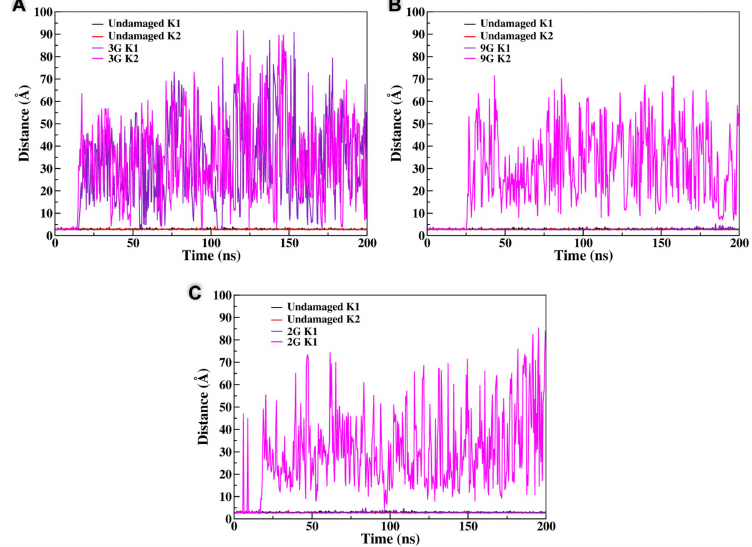
Figure 4. Time evolution of the distance between the central K + and the undamaged guanine oxygen atom for the 3G ( A ), 9G ( B ), and 2G ( C ) lesions, respectively. The time evolution of the distance for the undamaged quadruplex is also reported for